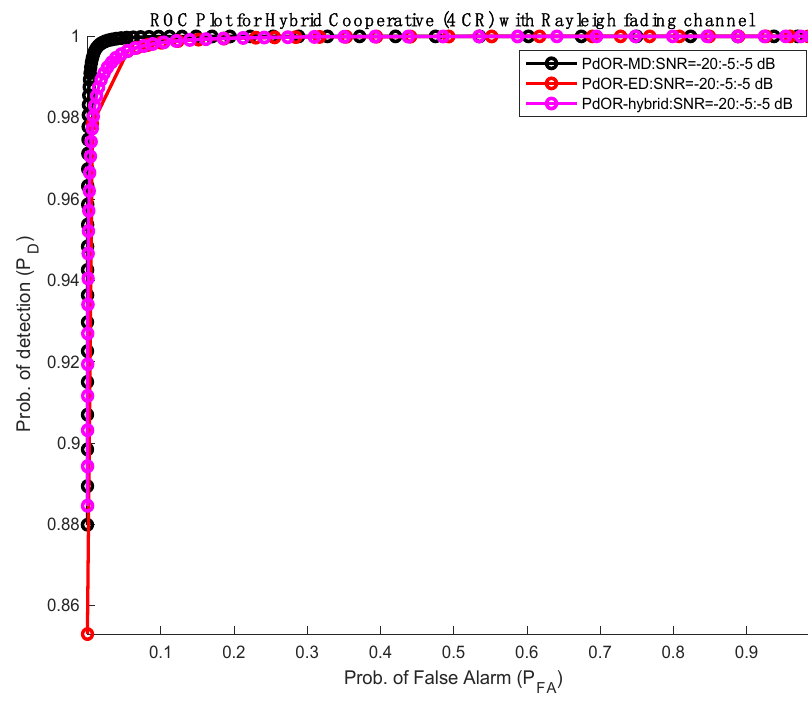
Figure 6. Hybrid detector under CSS (4) : OR for case 1.